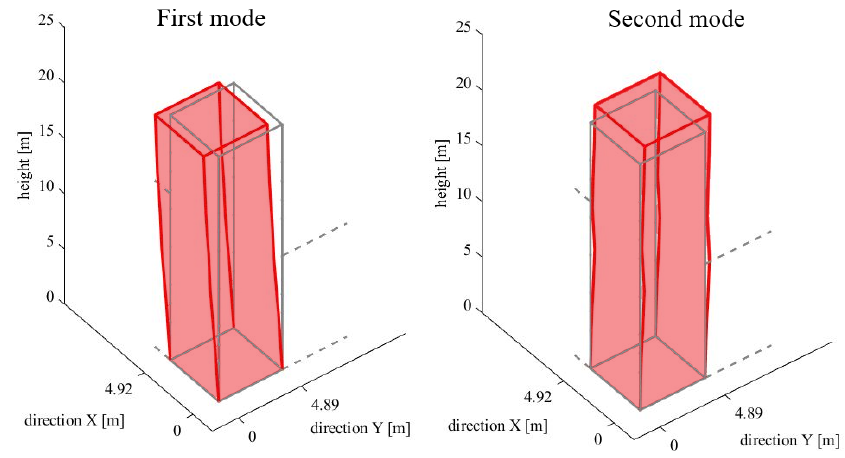
Figure 22. Experimental mode shapes.